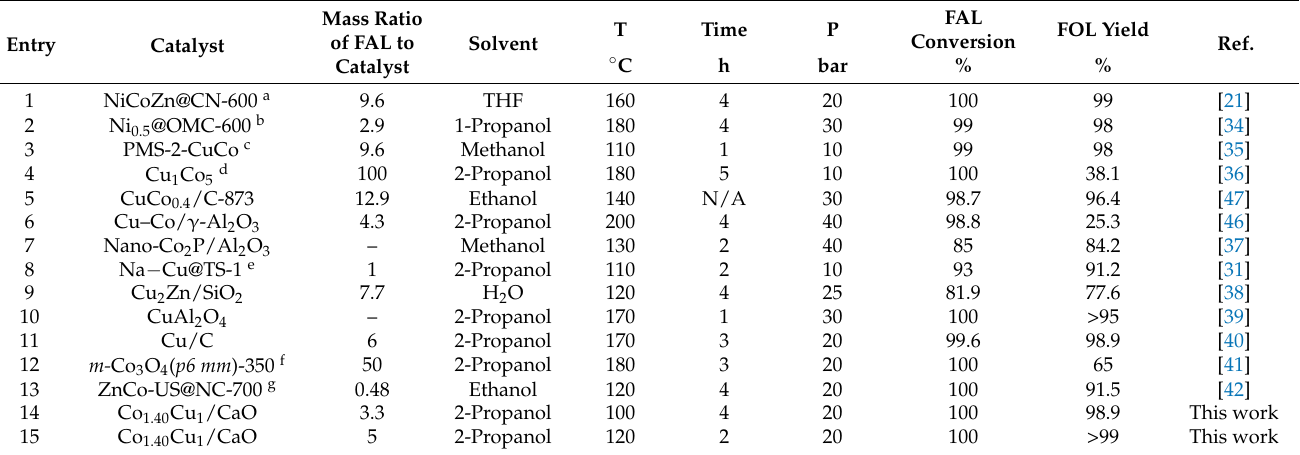
Table 2. Recent development of non-noble metal catalysts for FAL hydrogenation to FOL in a batch reactor under H 2 atmosphere.